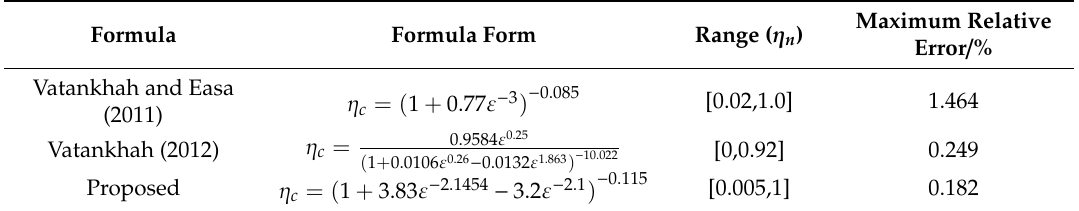
Table 2. The comparison of di ff erent formulas for the critical depth of a circular section.